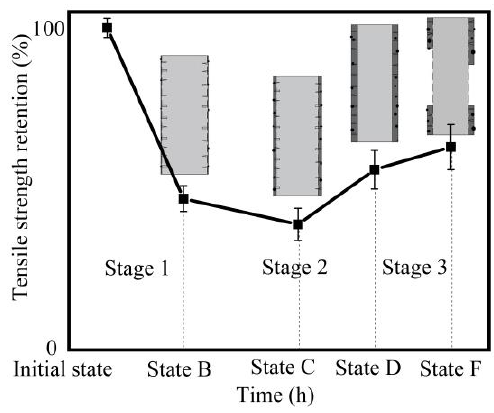
Figure 12. Tensile strength evolution for basalt fibers treated in NaOH solution.